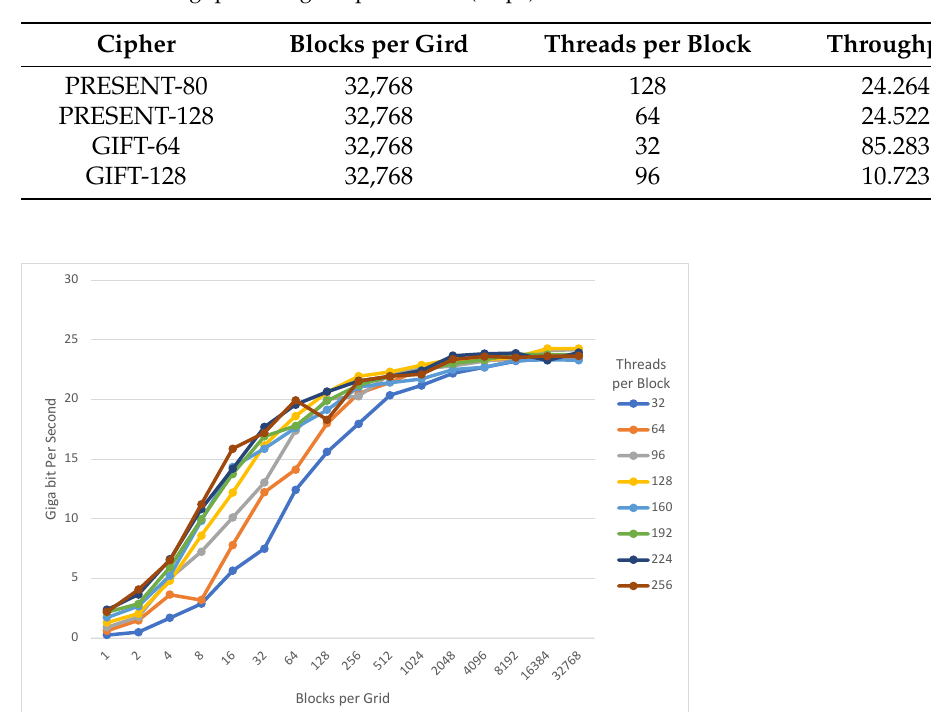
Table 4. The highest throughput results of the data encryption version of the proposed technique. The unit of throughput is Gigabit per second (Gbps).